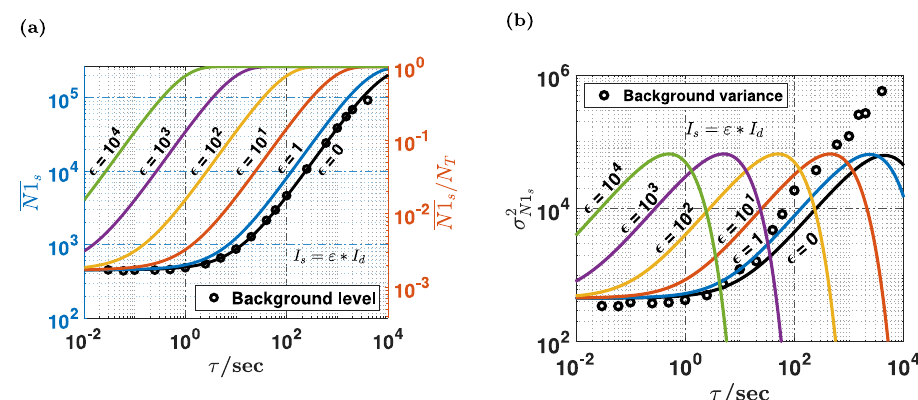
Figure 2. Comparison between simulation and experiments. From the CIC and I d values measured for each pixel, results of numerical simulation are shown (solid lines) for the averaged total detector count N 1 and the averaged counting probability N 1 / N T ( a ), and for the count variance σ 2 N 1 ( b ), as a function of the exposure time τ and for different values of the photon rate φ arriving on all individual pixels. φ is expressed as a fraction ε of the dark current I d . Experimental data acquired for the dark response φ shown (black circles) after removal of cosmic rays and outlier